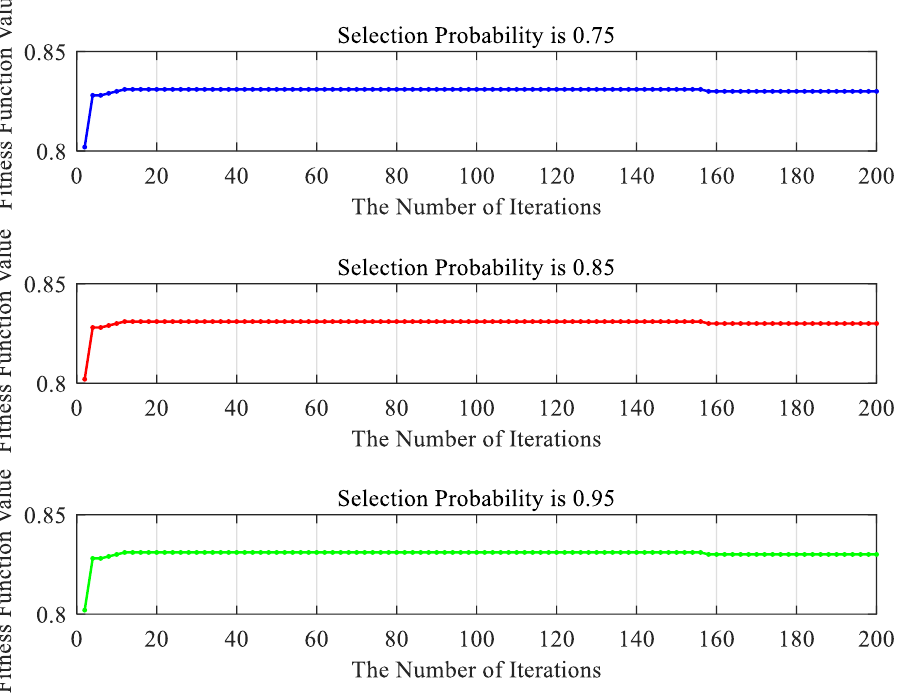
Figure 13. Influence of selection operator on GA.